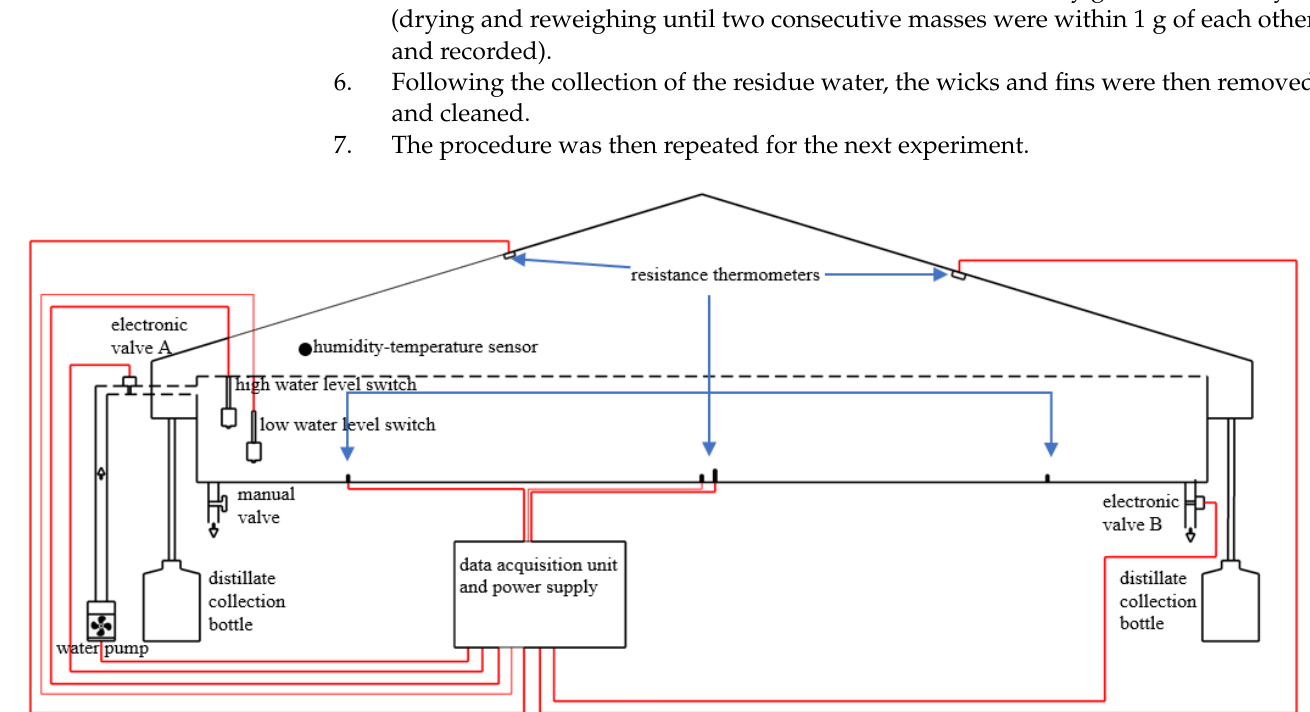
Figure 1. Experimental setup of the solar still installed in a north-south orientation: ( a ) northern side, ( b ) southern side.